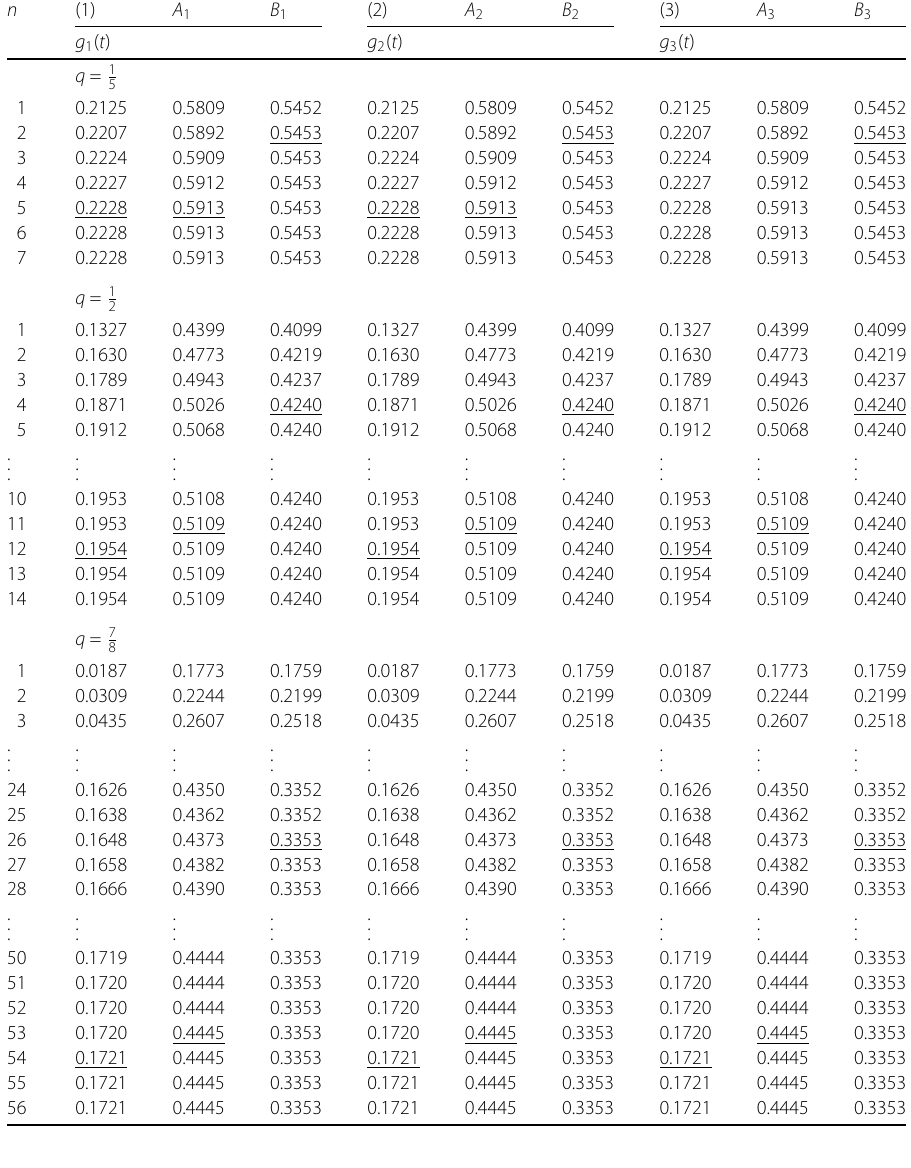
, (2) (cid:13) I σ –1 q [ g 2 ] (cid:13) L 1